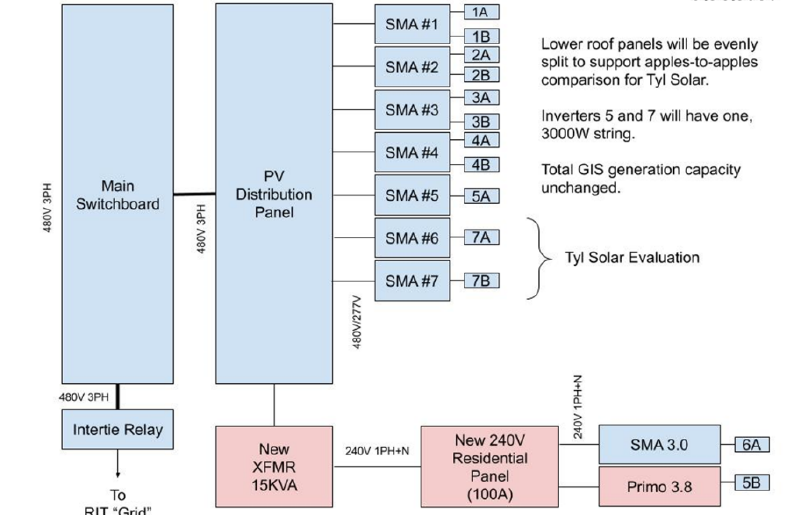
Figure 3. Block diagram of microgrid modifications.